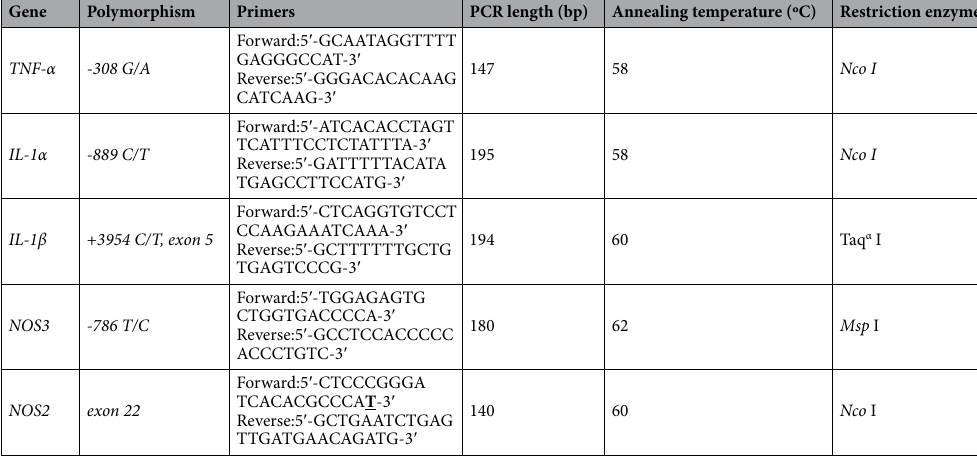
Table 1. Oligonucleotide primer sequences, PCR conditions and restriction enzymes used for genotyping and sequencing of the different polymorphisms studied. The underlined bases in the primers differ from the original sequences and served to introduce a restriction site or to disrupt a natural restriction site within the primer sequence.